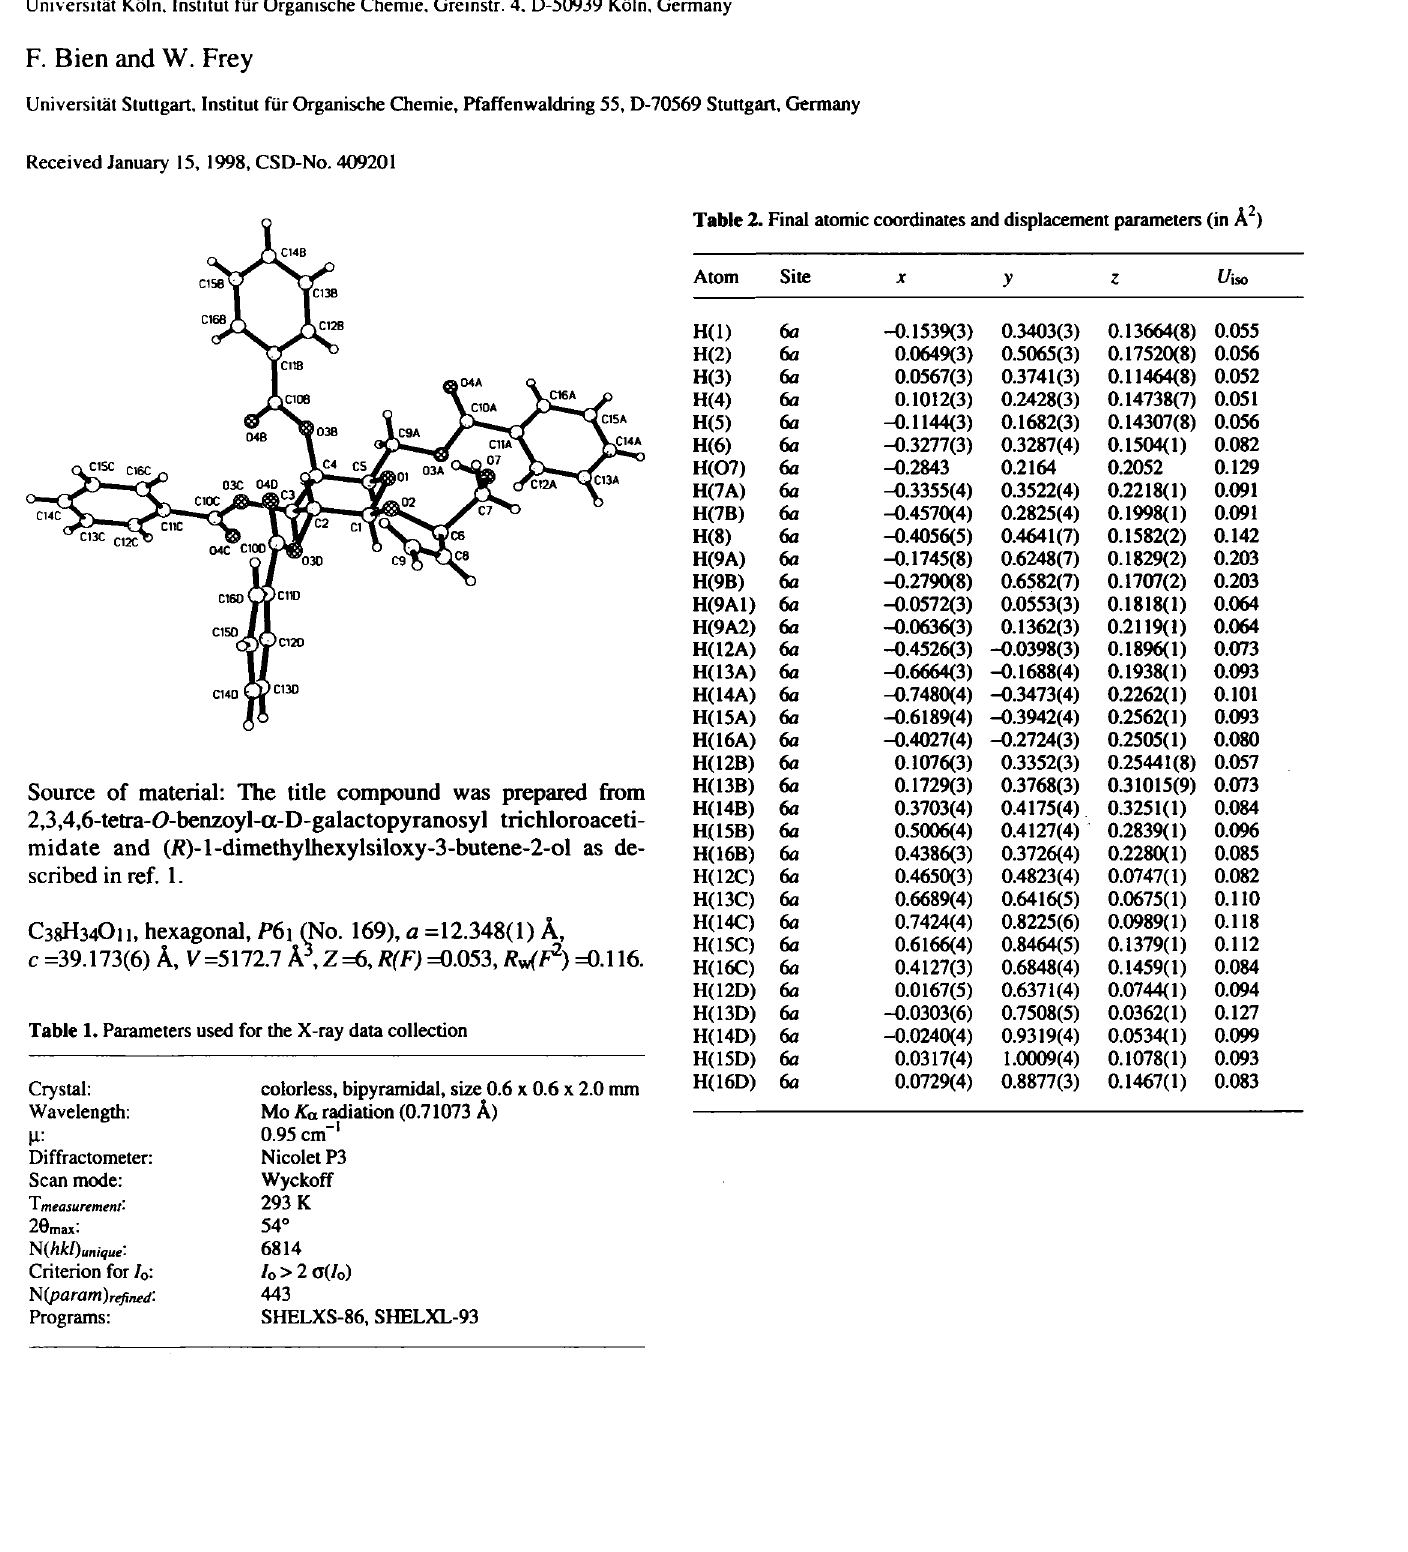
Table 2. Final atomic coordinates and displacement parameters (in